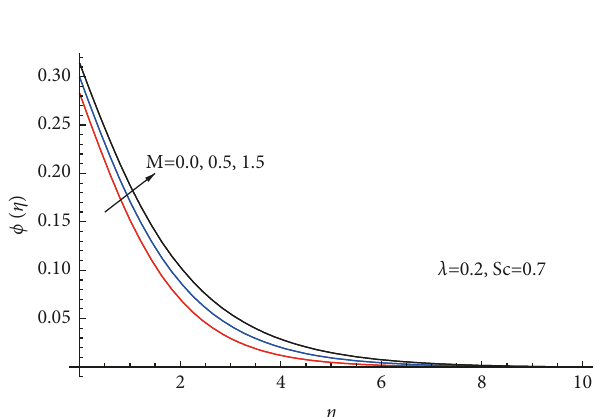
Figure 3: Influence of M on θ ( η ) .